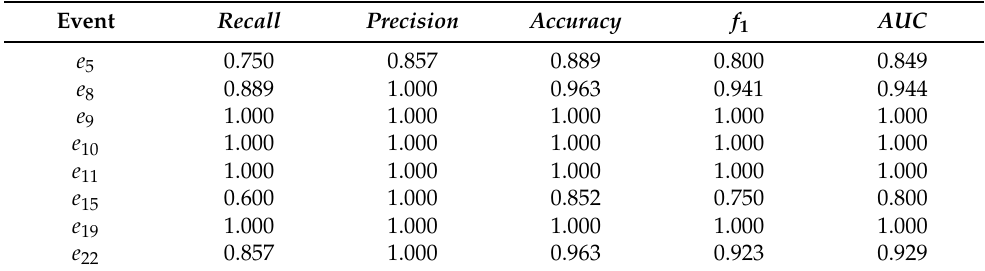
Table 6. Performance results for the logistic regression model